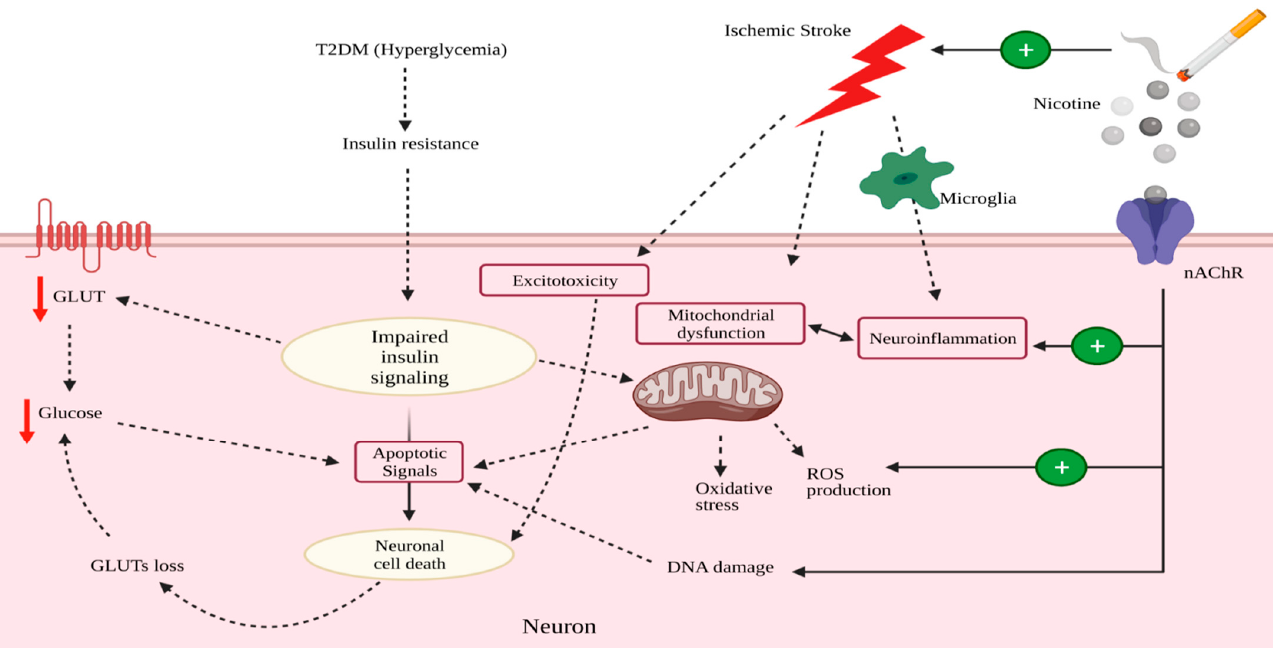
Figure 3. Effects of nicotine/smoking and diabetes on neuronal glucose utilization in ischemic stroke (created in BioRender).